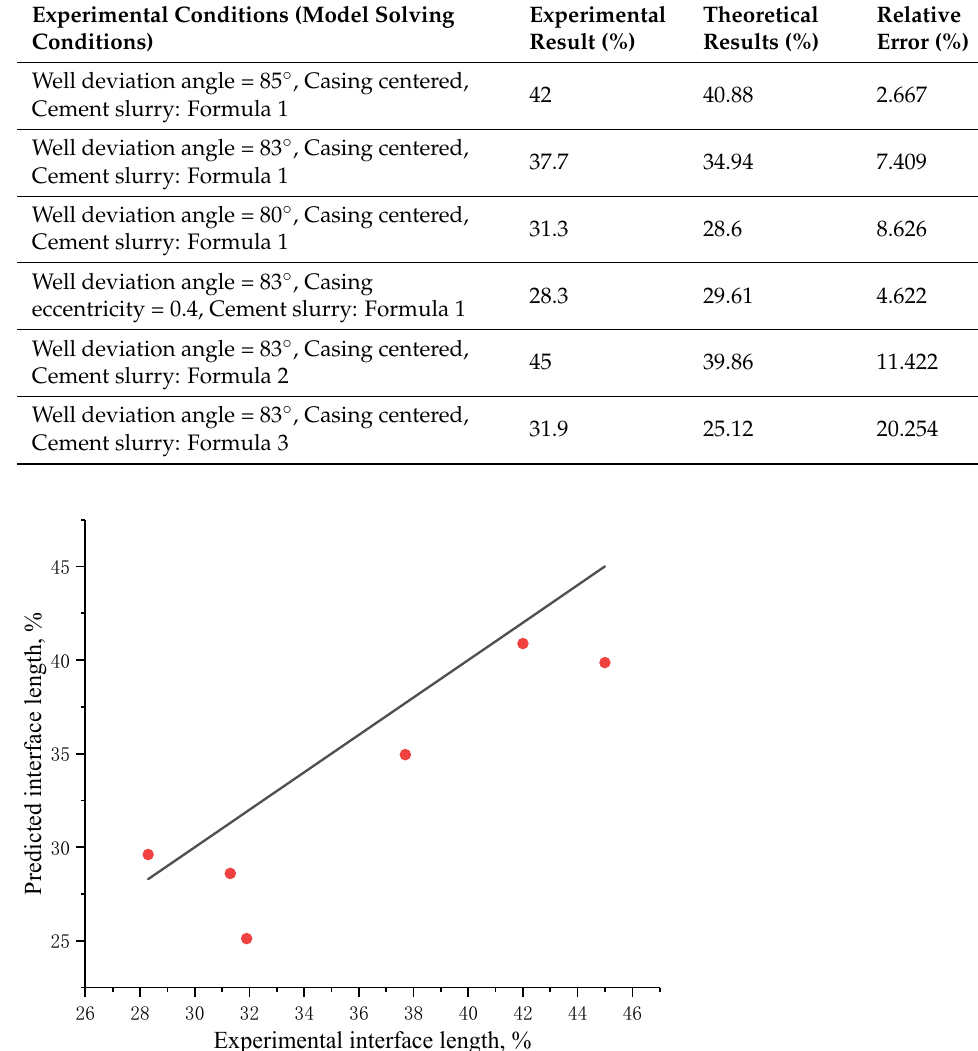
Table 2. Certification of theoretical model for cementing displacement interface.